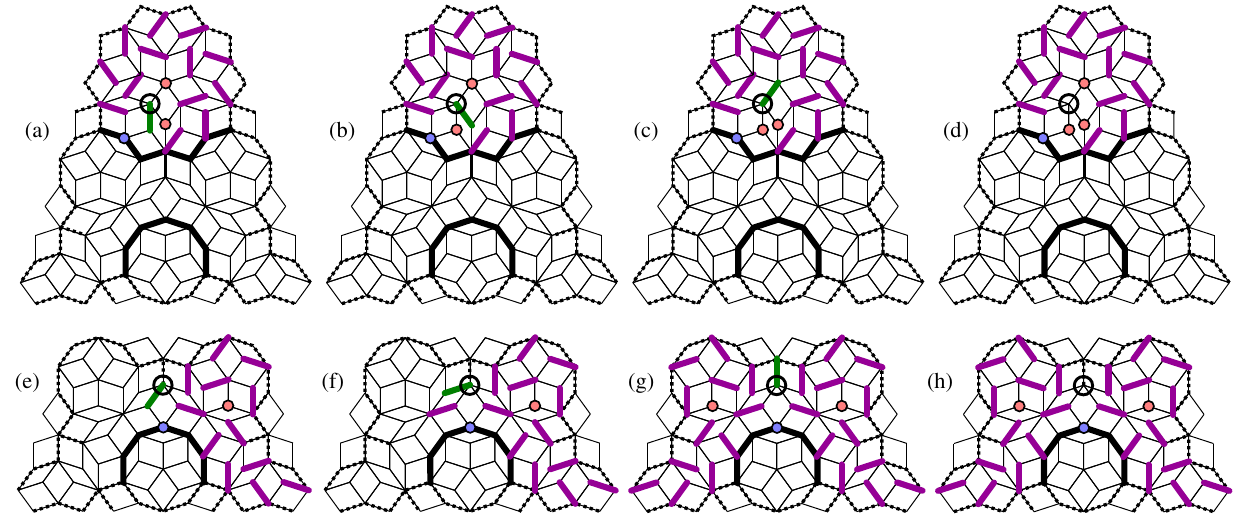
FIG. 19. Proof no monomer can be based on a 4-vertex in a maximum matching. See accompanying text in Appendix A 2.